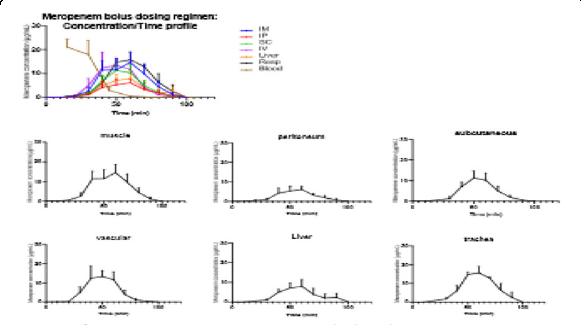
Fig. 1 (abstract 000840). Meropenem bolus dosing regimen: concentration/time